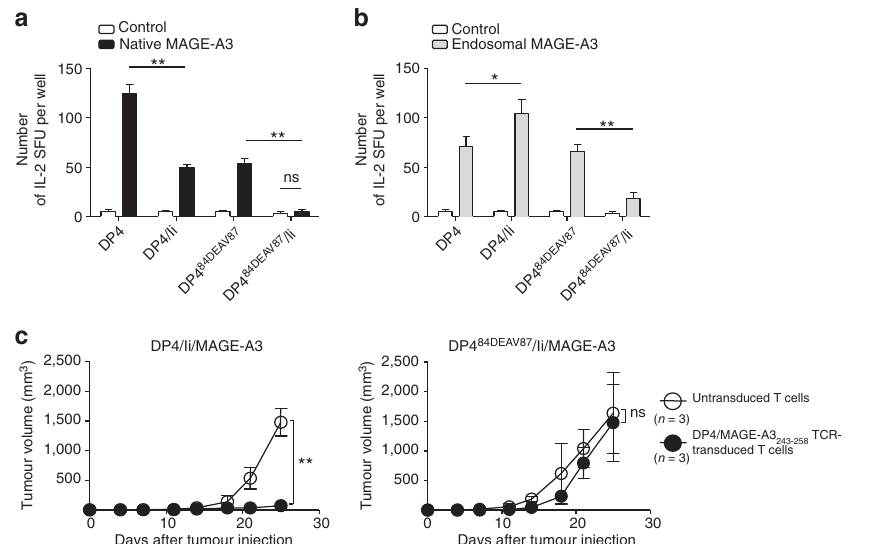
Figure 7 | DP 84GGPM87 but not DP 84DEAV87 constitutively presents peptides derived from intracellular proteins regardless of Ii expression. ( a , b ) The indicated K562-based aAPCs were transiently transfected with a retrovirus vector encoding IRES-EGFP (control) or a native ( a ) or endosome-targeted ( b ) form of MAGE-A3 linked with IRES-EGFP. Transient transfection efficiencies were normalized to EGFP expression measured by flow cytometry. DP4/MAGE-A3 243–258 CD4 þ T cells were stimulated with the indicated APCs and IL-2 secretion was measured by ELISPOT analysis. Data shown represent means ± s.d.’s of triplicates. ( c ) NSG mice were subcutaneously inoculated with 2 (cid:3) 10 6 K562 cells stably expressing DP4/Ii/MAGE-A3 or DP4 84DEAV87 /Ii/MAGE-A3. Two days later, the mice were treated with 4 (cid:3) 10 7 CD3 þ T cells untransduced or transduced with DP4/MAGE-A3 243–258 TCR. The mean tumour size for each group is represented as the average ± s.d. of three mice. There was no significant difference in the tumorigenicity of the two cell lines (data not shown). Results are representative of three independent experiments. ns, not significant; * P o 0.05, ** P o 0.01 by unpaired, two-tailed Welch’s t Fig. 6a) 20,21 . compared